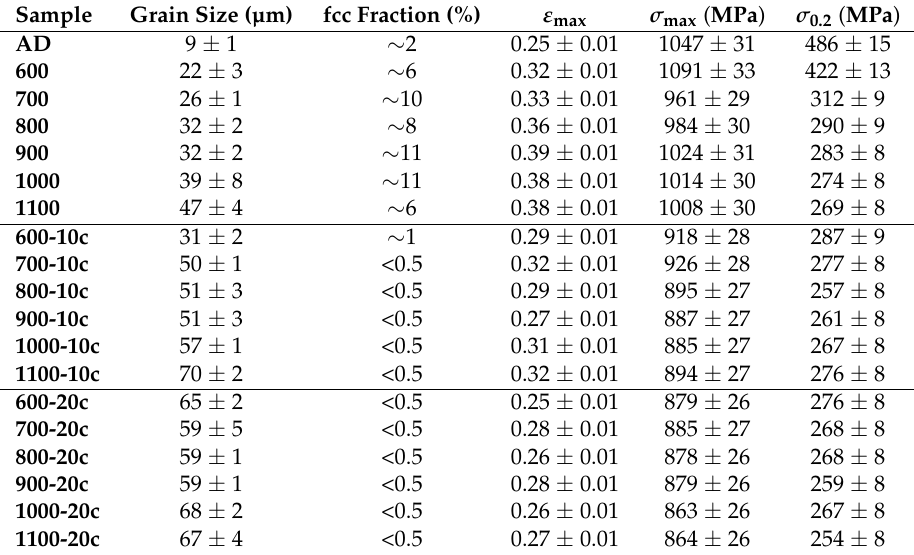
Table 1. Microstructural and mechanical data of all the tested sample sets.